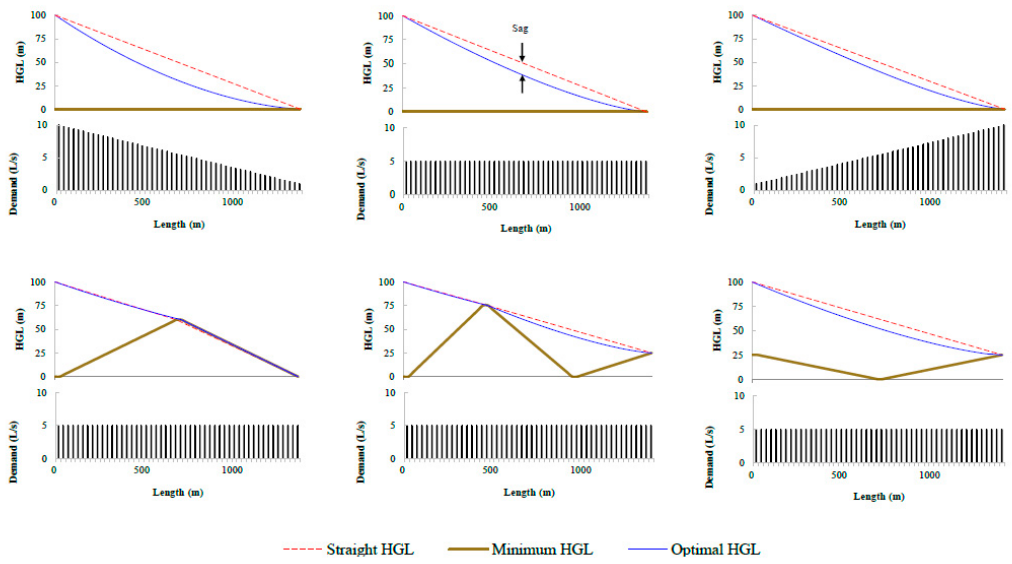
Figure 1. Comparison of Hydraulic Grade Lines ( HGL ) resulting from Different Demand Configurations and Minimum HGL .